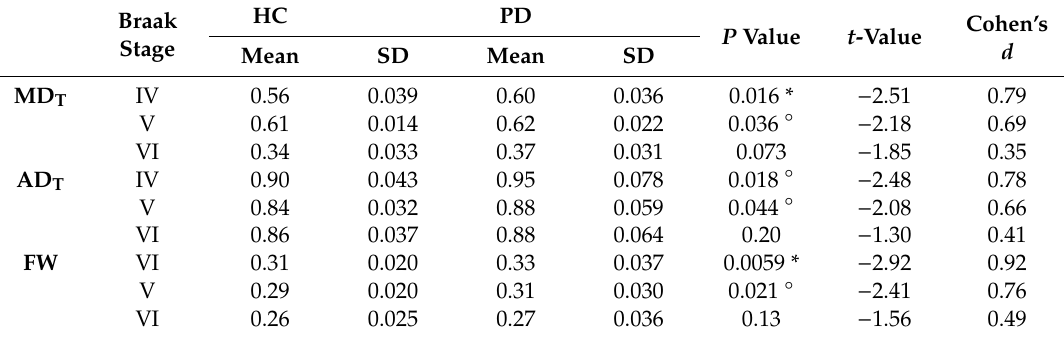
Figure 4. ( A ) Region-of-interest analyses of gray matter areas belonging to Braak stages IV, V, and VI. ( B ) Mean values for FW imaging indices (MD T , AD T, and FW) of each area in healthy controls (white bars) and patients with PD (gray bars). AD T , free water-corrected axial diffusivity; FW, free water; HC, healthy controls; MD T , free water-corrected mean diffusivity; PD, Parkinson’s disease. Table 5. Region-of-interest analyses of free-water imaging indices in the gray matter of patients with Parkinson’s disease and healthy controls according to the Braak staging.